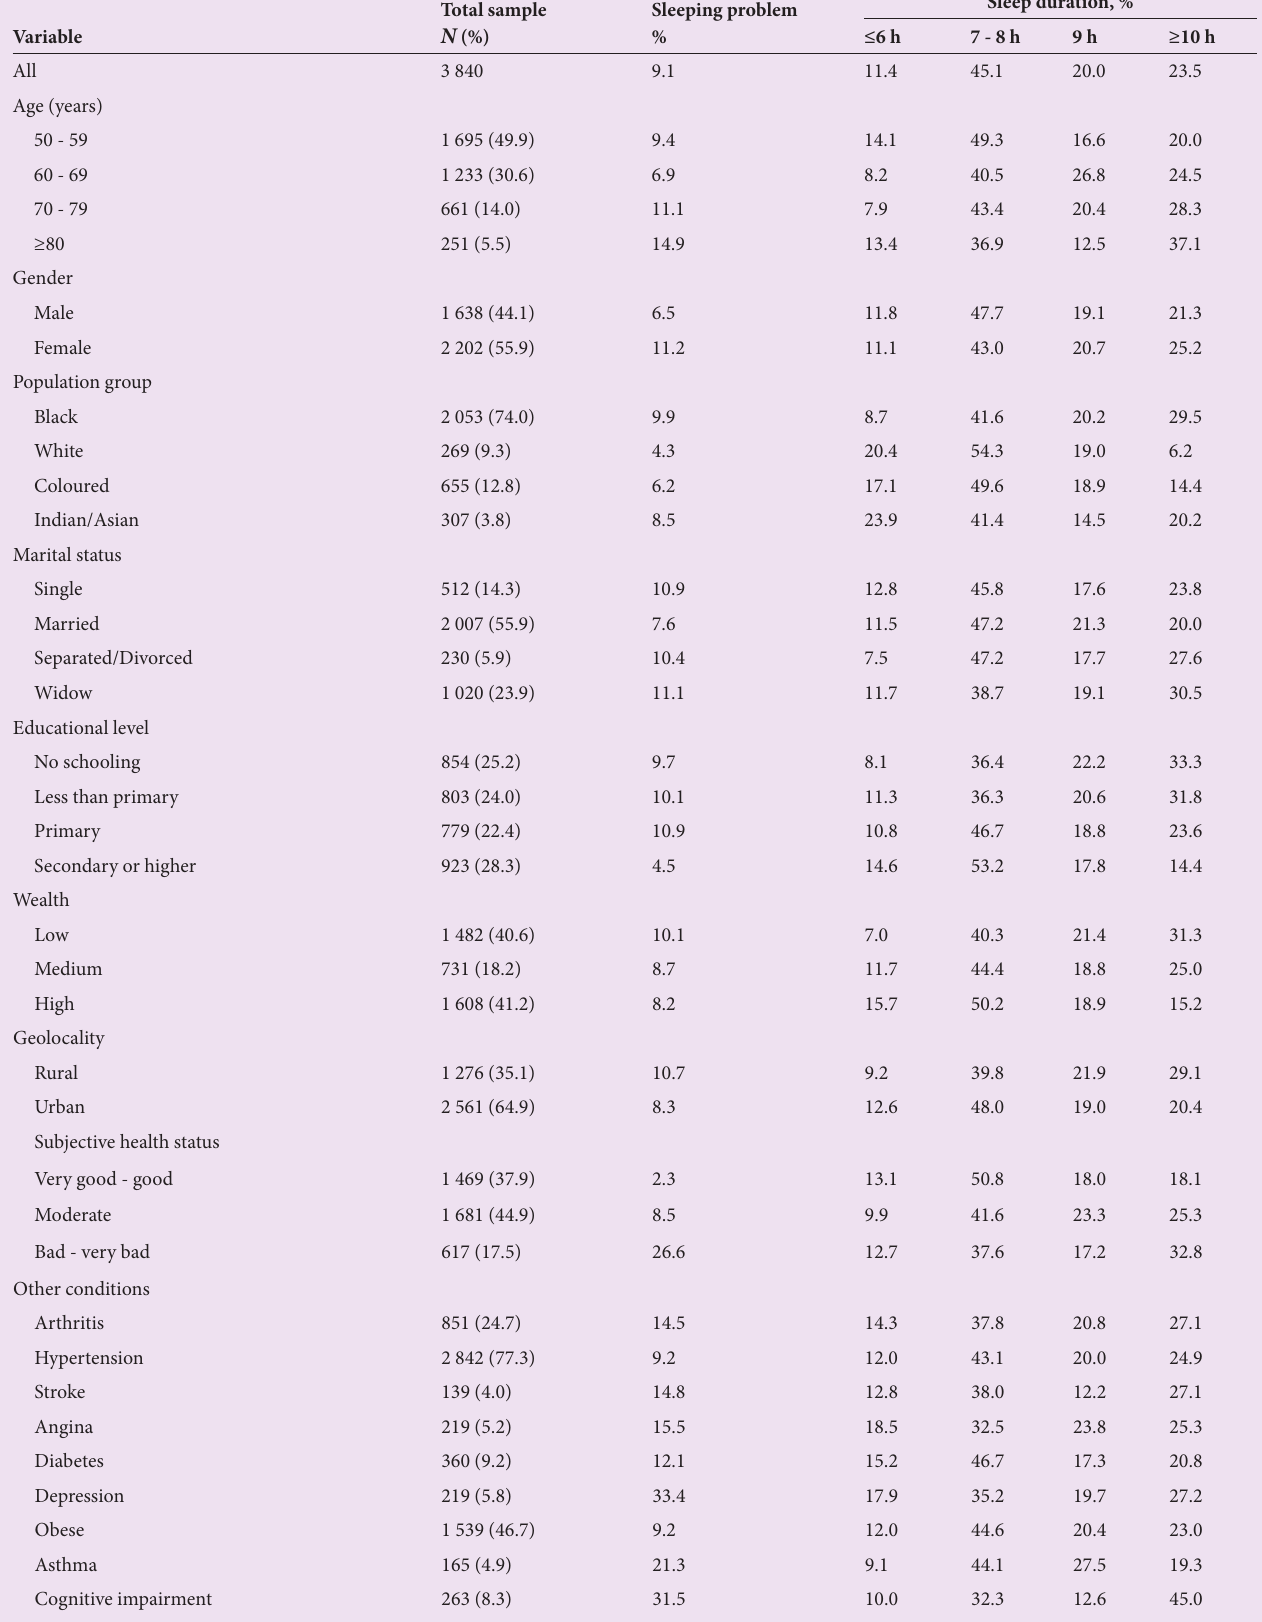
Table 1. Sample characteristics, sleeping problems and sleep duration among older South Africans